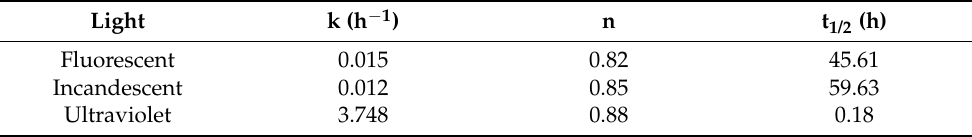
Table 5. Parameters of mathematical modeling and kinetic parameters of light degradation of anthocyanins in grumixama extracts obtained by the Weibull